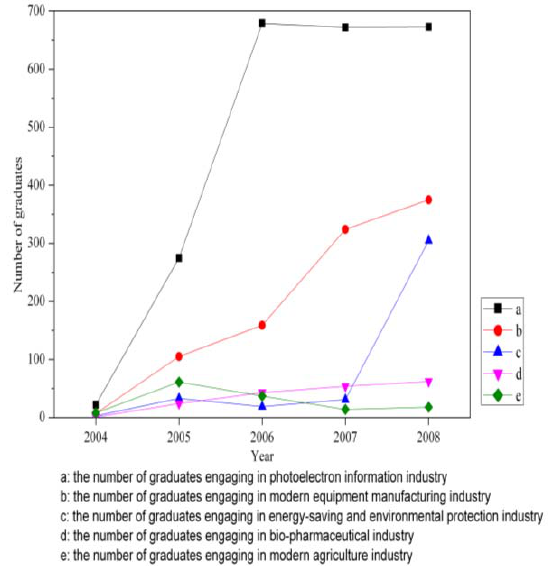
Fig. 8 The number of gradutes engaging in five pillar industies